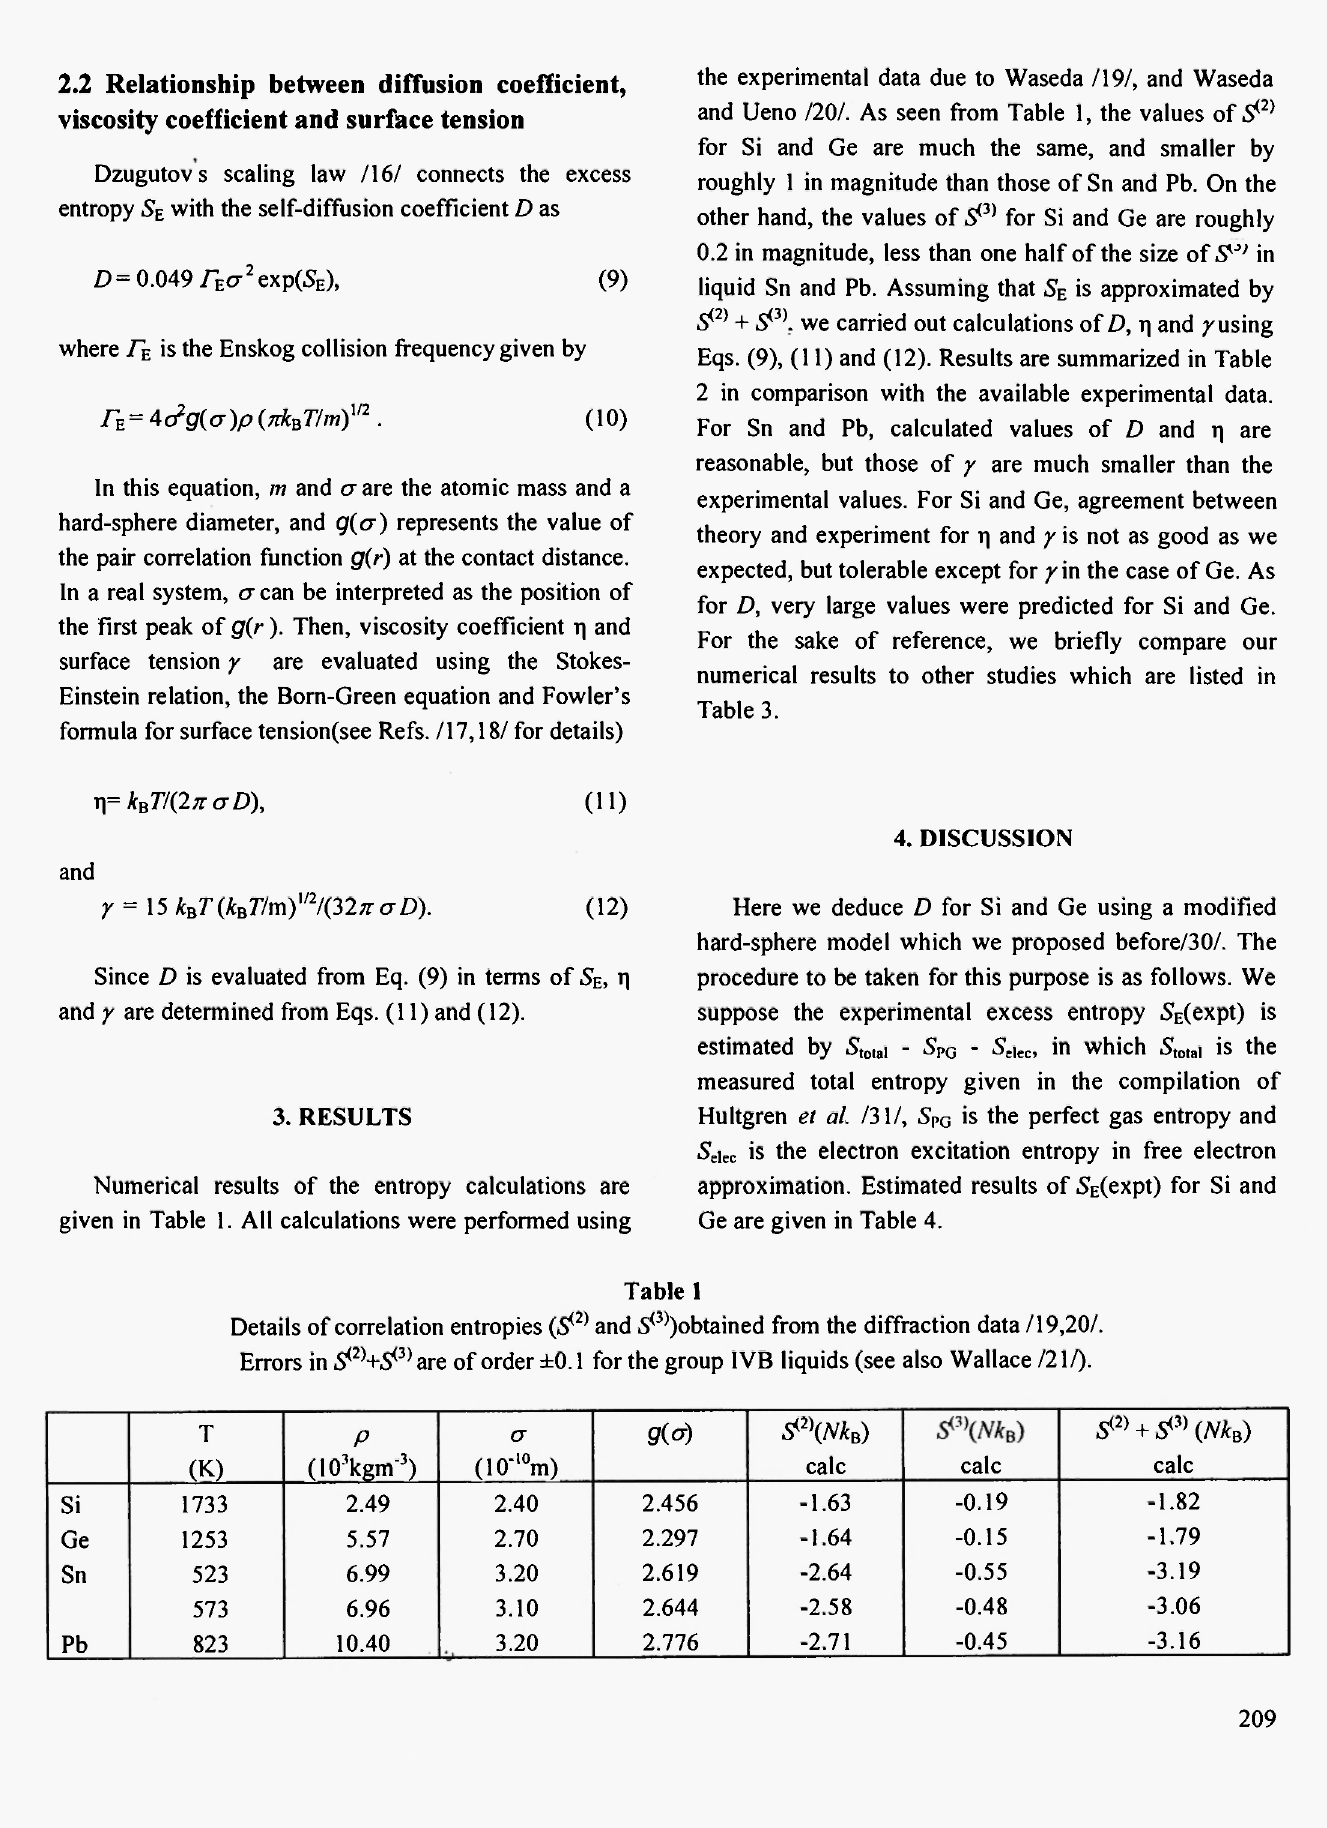
Details of correlation entropies (5 <2> and S* 3) )obtained from the diffraction data